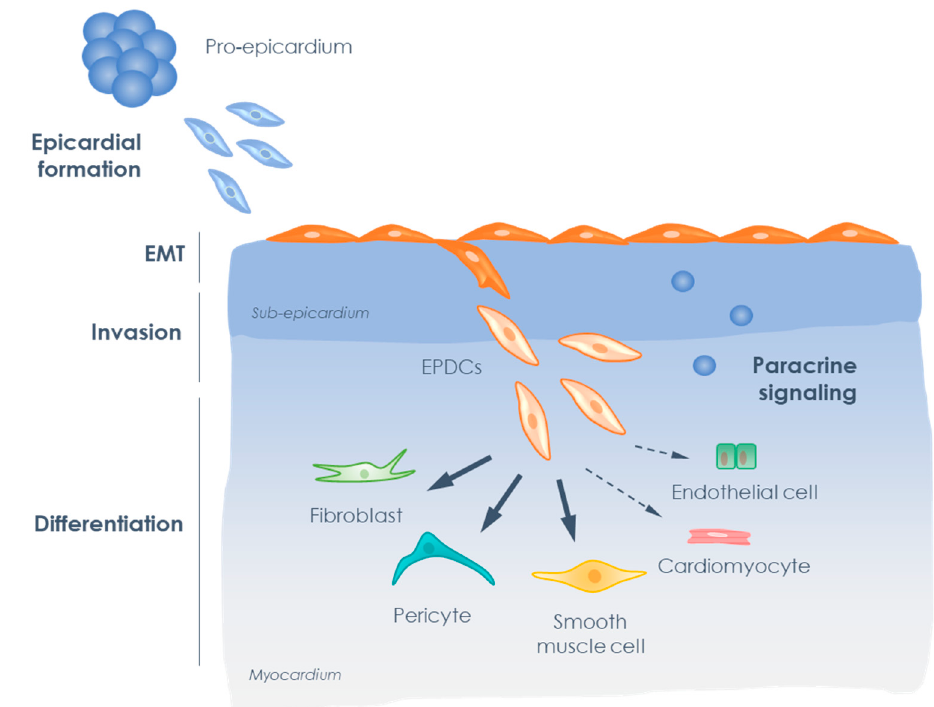
Figure 2. Schematic overview of epicardial behavior during development. Pro-epicardial cells migrate towards the heart and cover it to form the epicardium. When the epicardium has enveloped the heart, cells start to undergo epithelial to mesenchymal transition (EMT). This allows the epicardial derived cells to invade into the heart and differentiate into various cell types, mainly cardiac fibroblasts, smooth muscle cells, and pericytes. In addition, epicardial cells secrete paracrine factors that contribute to the development of the heart.